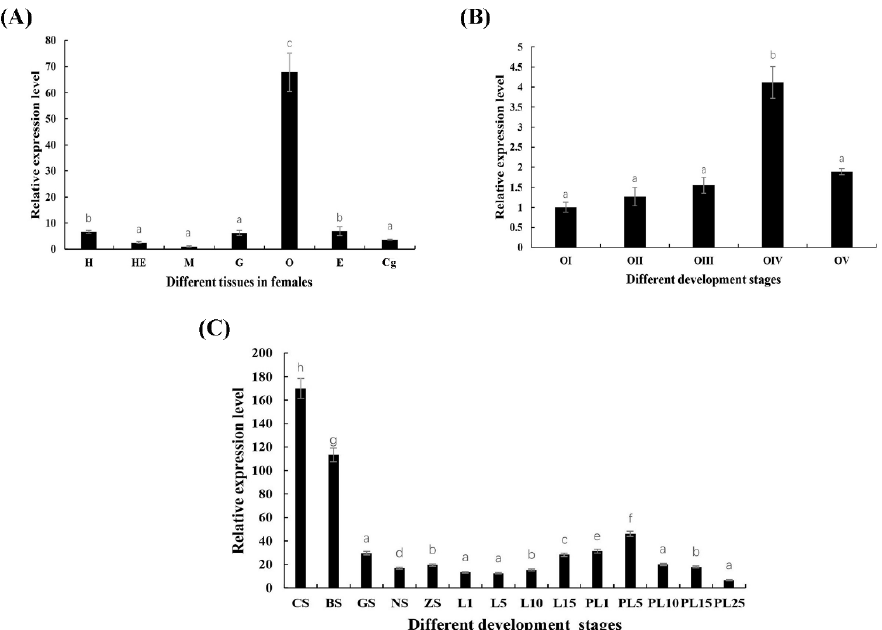
Figure 4. The expression pattern of the Mn-CTSD gene in different tissues ( A ) and different stages of ovarian maturation( B ) and developmental stages ( C ) of M. nipponense were measured by qPCR. E — eye, Cg — cerebral ganglion, H — heart, He — hepatopancreas, G — gill, M — muscle, O — ovary; Data are presented as the mean ± SD ( n = 6). p < 0.05 was considered to be statistically significant. significant a, b, c, d, e, f indicate significant differences.